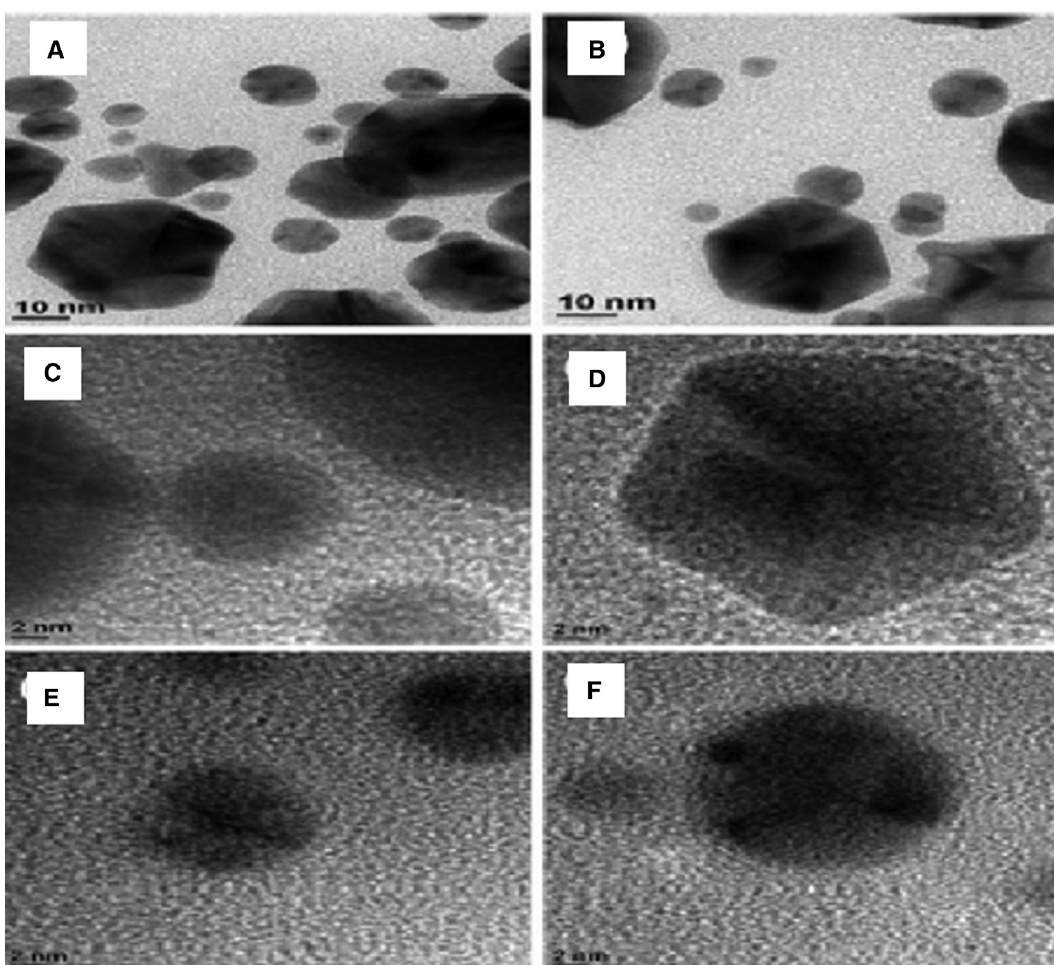
Figure 9 High-resolution transmission electron microscopy (HR-TEM) analysis of (A) to (F) various shapes and projections of gold nanoparticles.